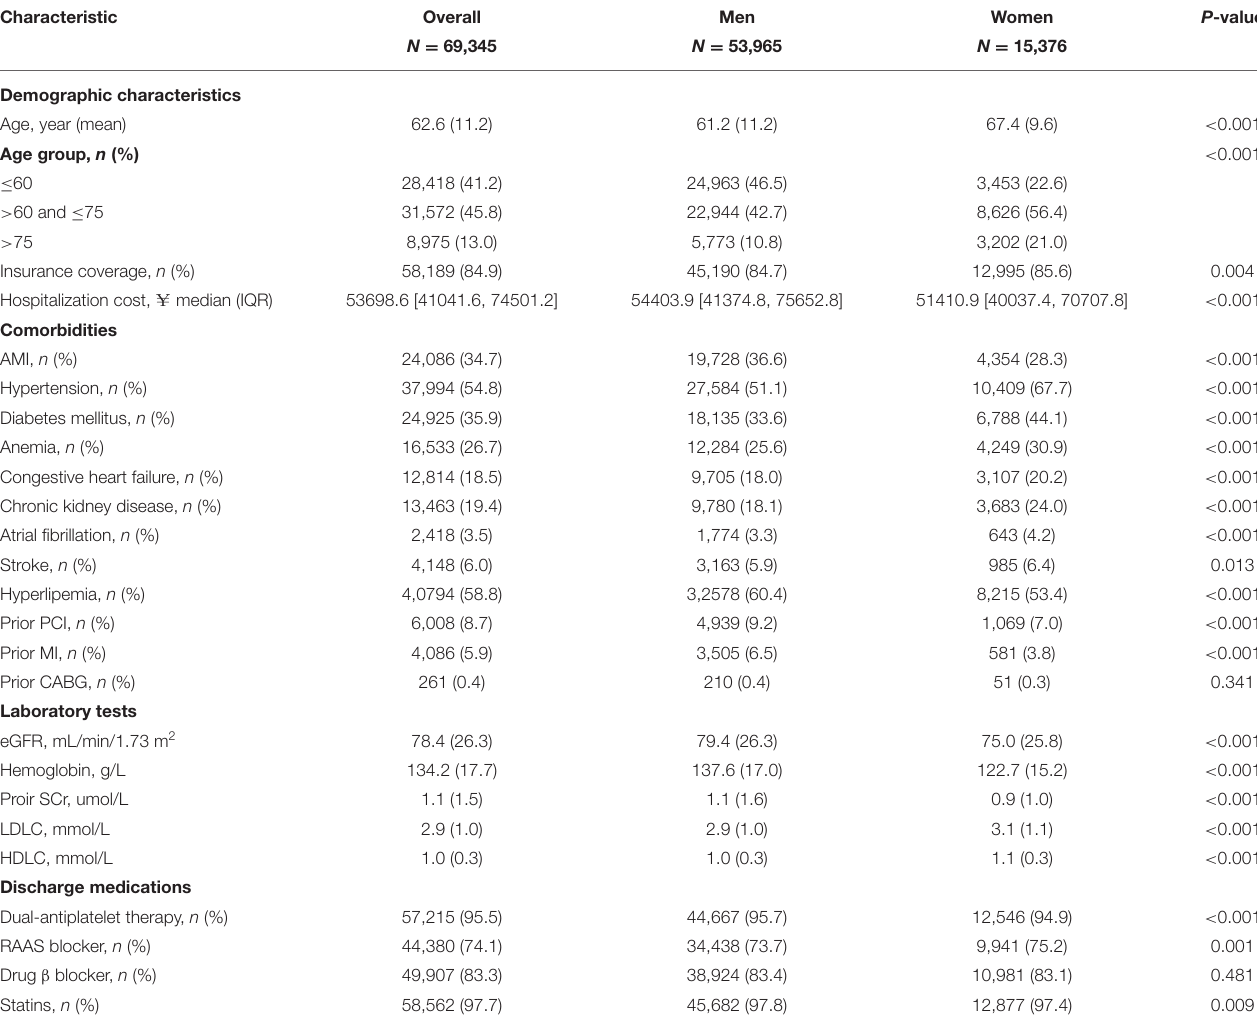
TABLE 2 | Demographic and clinical characteristics of patients undergoing PCI from 2007 to 2020. Characteristic